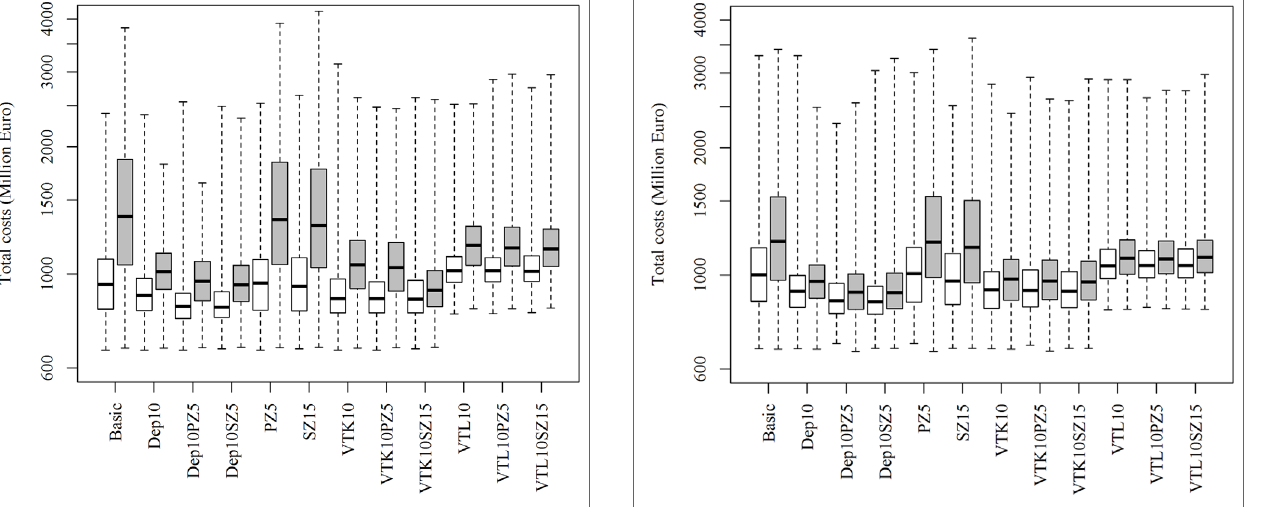
FigUre 4 | Total costs using different strategies to control 1,000 simulated FMD epidemics in Denmark, all initiated in cattle herds, when the probability of local spread is decreased (white boxes) or increased (gray boxes) by 25% . The basic scenario represents the EU and Danish control regulations (Basic), combined with the enlargement of the protection zone to 5 km (PZ5) and the surveillance zone to 15 km (SZ15), pre-emptive depopulation (Dep) over a 1-km radius around detected herds, and suppressive (VTK) or protective (VTL) emergency vaccination over a 2-km radius around detected herds. Pre-emptive depopulation and vaccination were initiated following the detection of 10 infected herds (10H). Scenarios combining pre-emptive depopulation over 1 km, suppressive or protective emergency vaccination over 2 km and enlarged protection or surveillances zones are also